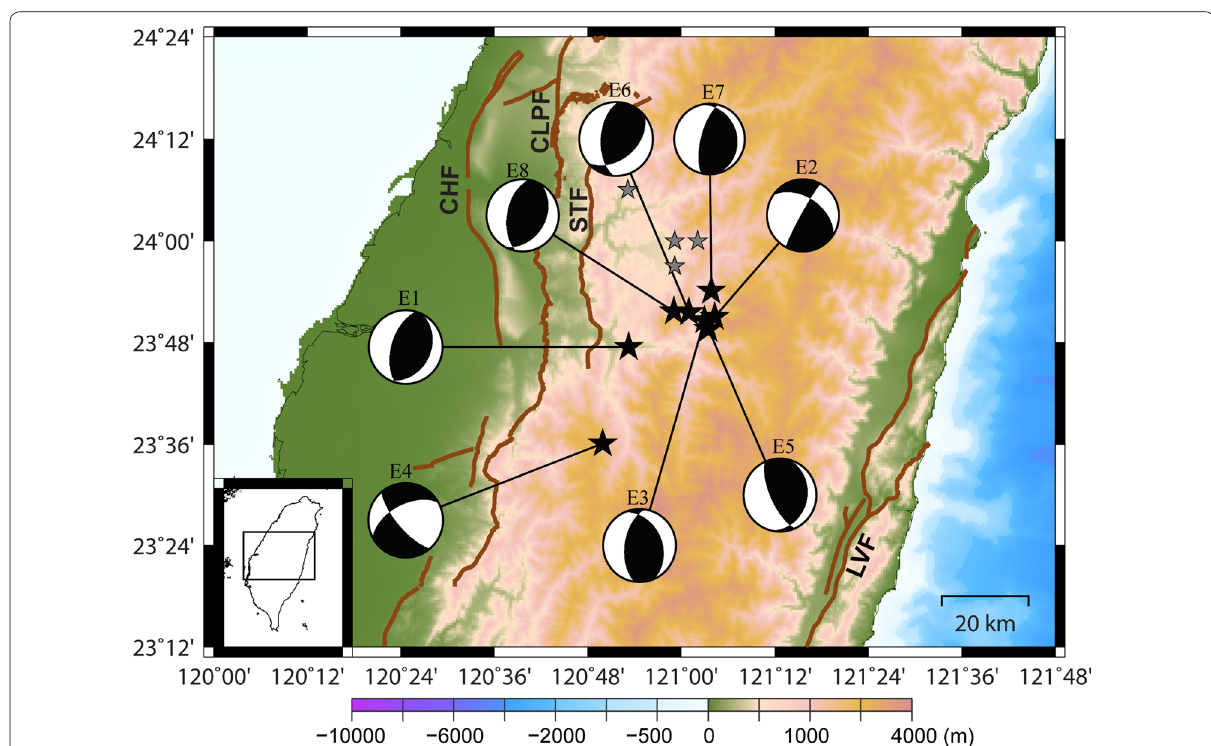
Fig. 1 Epicenters (black stars) and focal mechanisms for the eight moderate‑sized events that struck the Nantou area in 1999 and 2013, as listed in Table 1. The gray stars show the epicenters of the 1916 Nantou earthquake sequence. The active faults (thick lines) identified by Central Geological Survey of Taiwan are also shown. CHF Changhua fault, CLPF Chelungpu fault, STF Shuangtung fault, LVF Longitudinal Valley fault